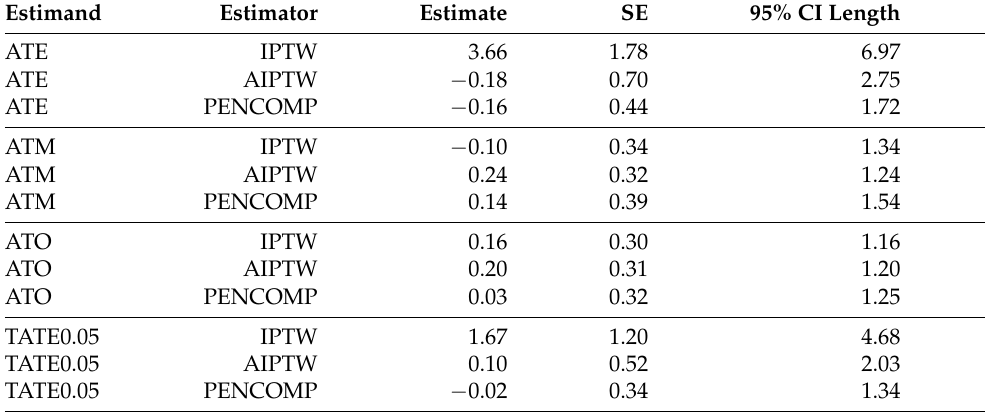
Table 7. MACS dataset: estimated one year change in CD4 count obtained using different